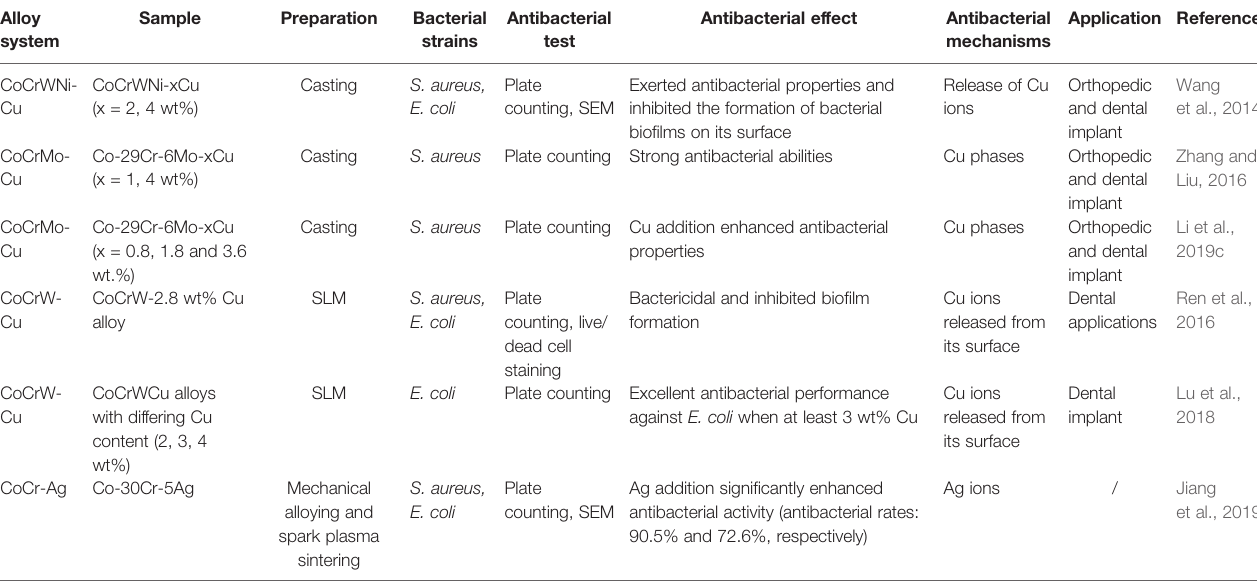
TABLE 2 | Engineered cobalt-based alloys with antibacterial